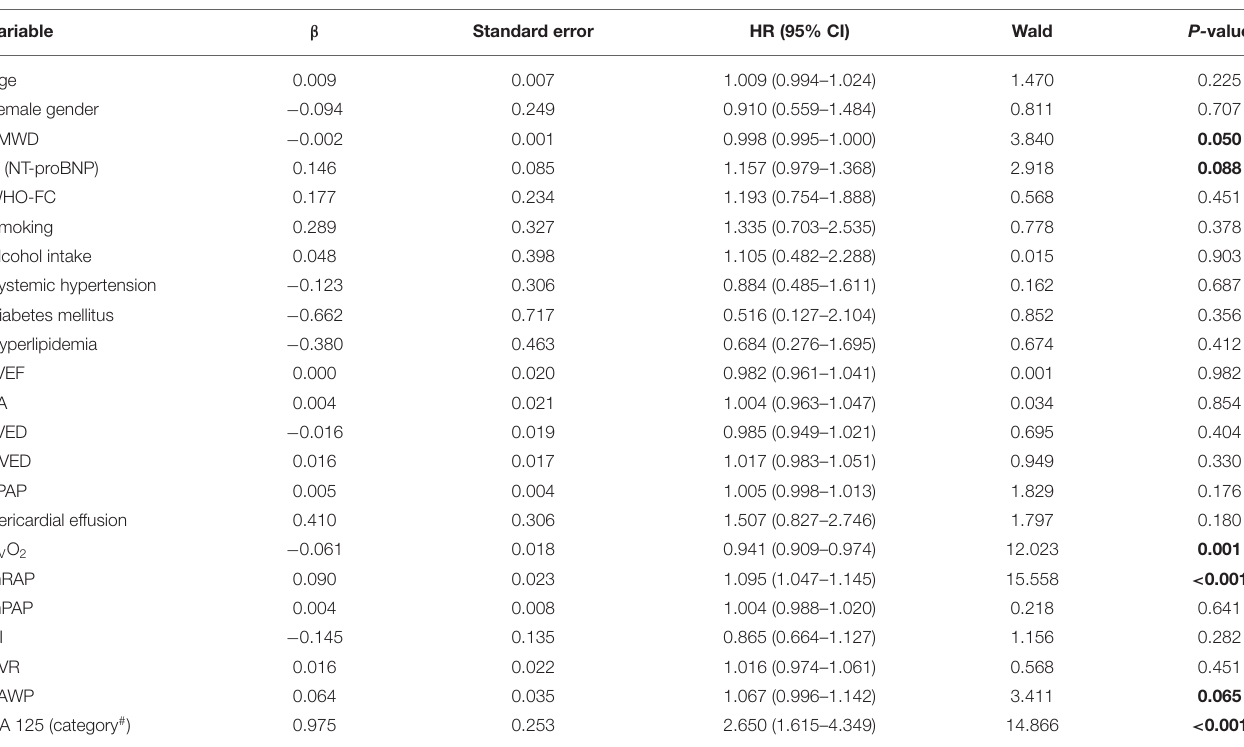
TABLE 3 | Univariate cox analysis of proportional risks for 1-year clinical